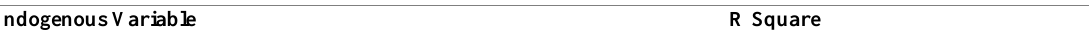
Table 6: Result of Coefficient of Determination